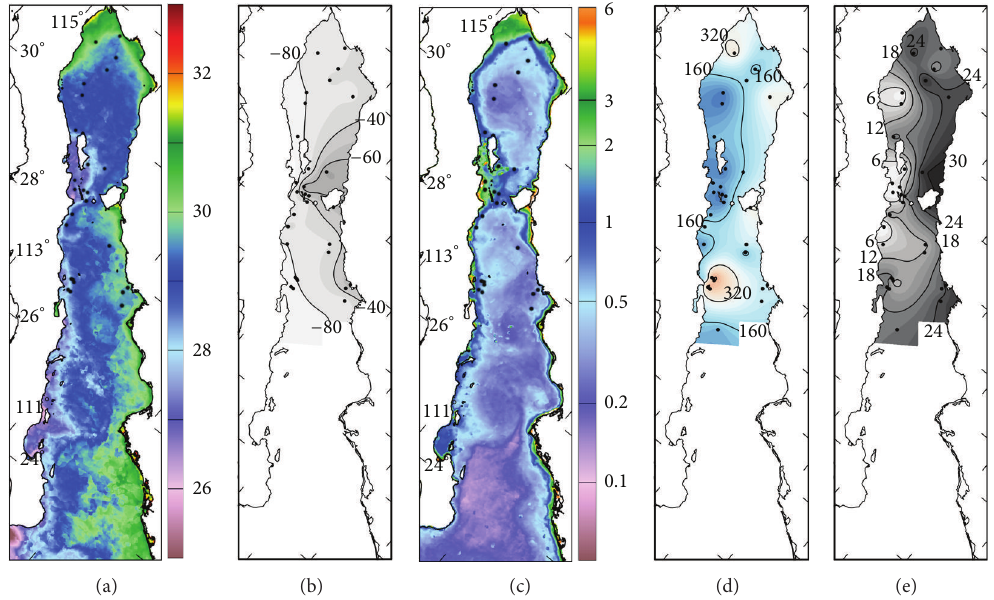
Figure 4: Biophysical characteristics during July. Composite of (a) SST ( ∘ C) and (c) CHL (mg m −3 ) satellite images of the Gulf of California. Distribution of (b) maximum stability depth (MSD), (d) zooplankton volumes, and (e) species richness.